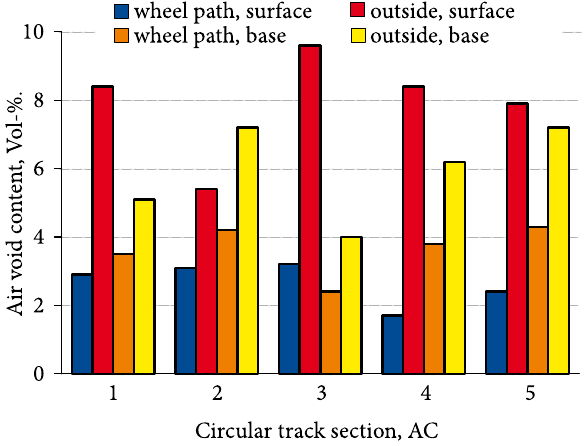
fig. 8. Air void content of surface and base course in and outside the wheel path for the circular track sections